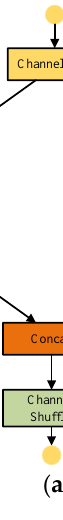
Figure 3. The architecture of ShuffleNetV2: ( a ) Basic module; ( b ) Down-sampling module.